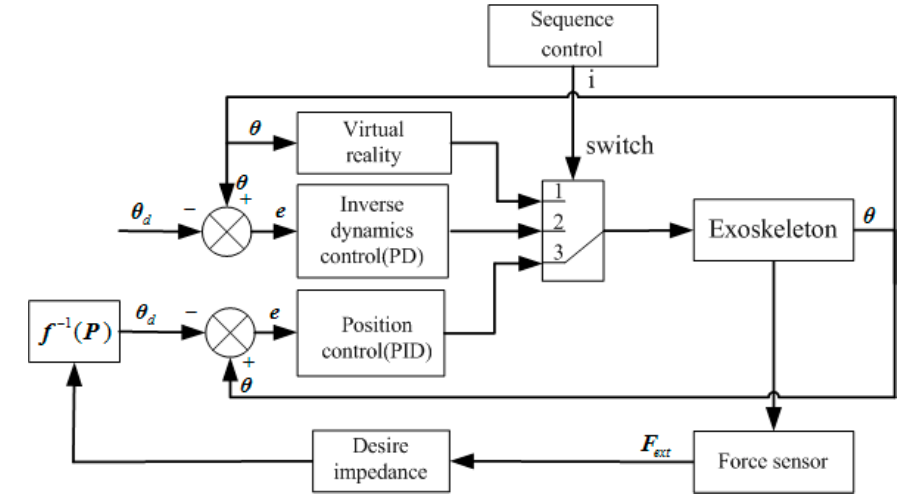
Figure 4. The active/passive control block diagram.